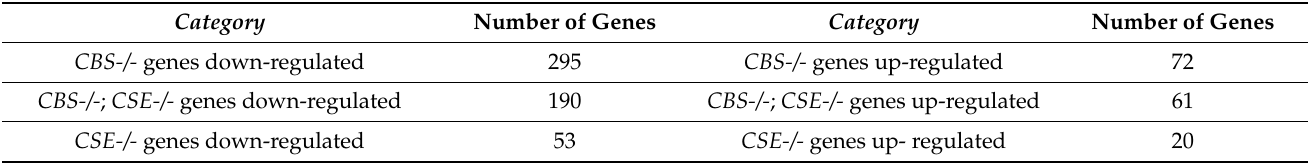
Table 1. The number of genes with altered expression in the strains with deletions after pairwise comparison to control strain 548492 (FDR <